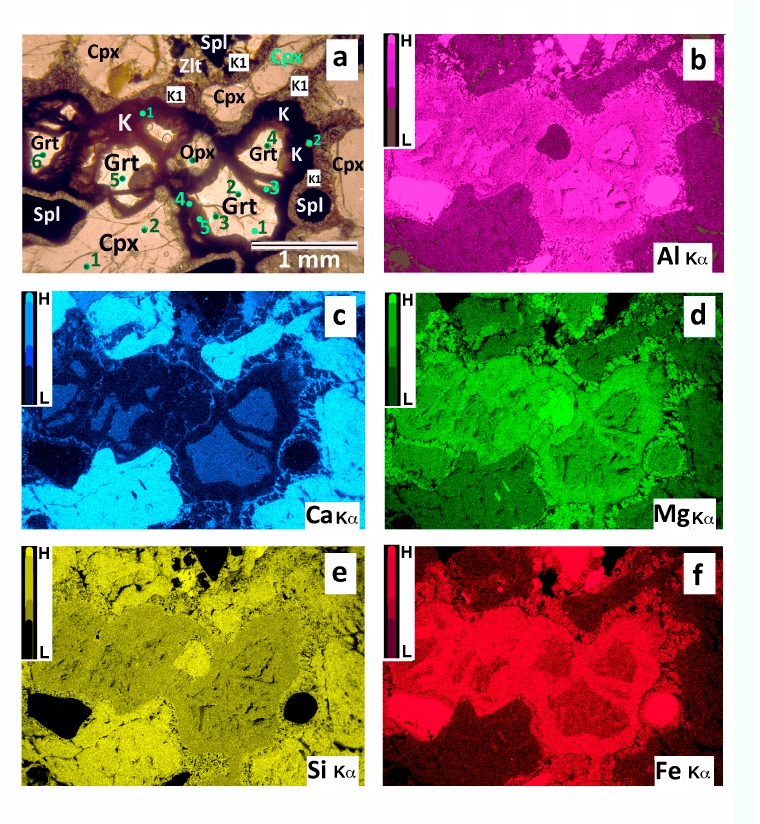
Figure 4. Dispersive energy spectrometer (EDS) chemical maps of a representative area of a polished section of the sample. Intensity of colors is proportional to the respective element abundances. ( a ) View of the area under the optical microscope (plane pol. transmitted light). Cpx = clinopyroxene; Grt = garnet; K = fine-grained kelyphite (replacing garnet); Opx = orthopyroxene; Spl = Al-spinel; K1 = coarse kelyphite (around spinel and pyroxenes); ZTL = Ca-K zeolite. Numbered circles in the mineral grains indicate location of Laser_ablation spot analyses. More explanation is given in the text. ( b ) Al chemical map. ( c ) Ca chemical map. ( d ) Mg chemical map. ( e ) Si chemical map. ( f ) Fe chemical